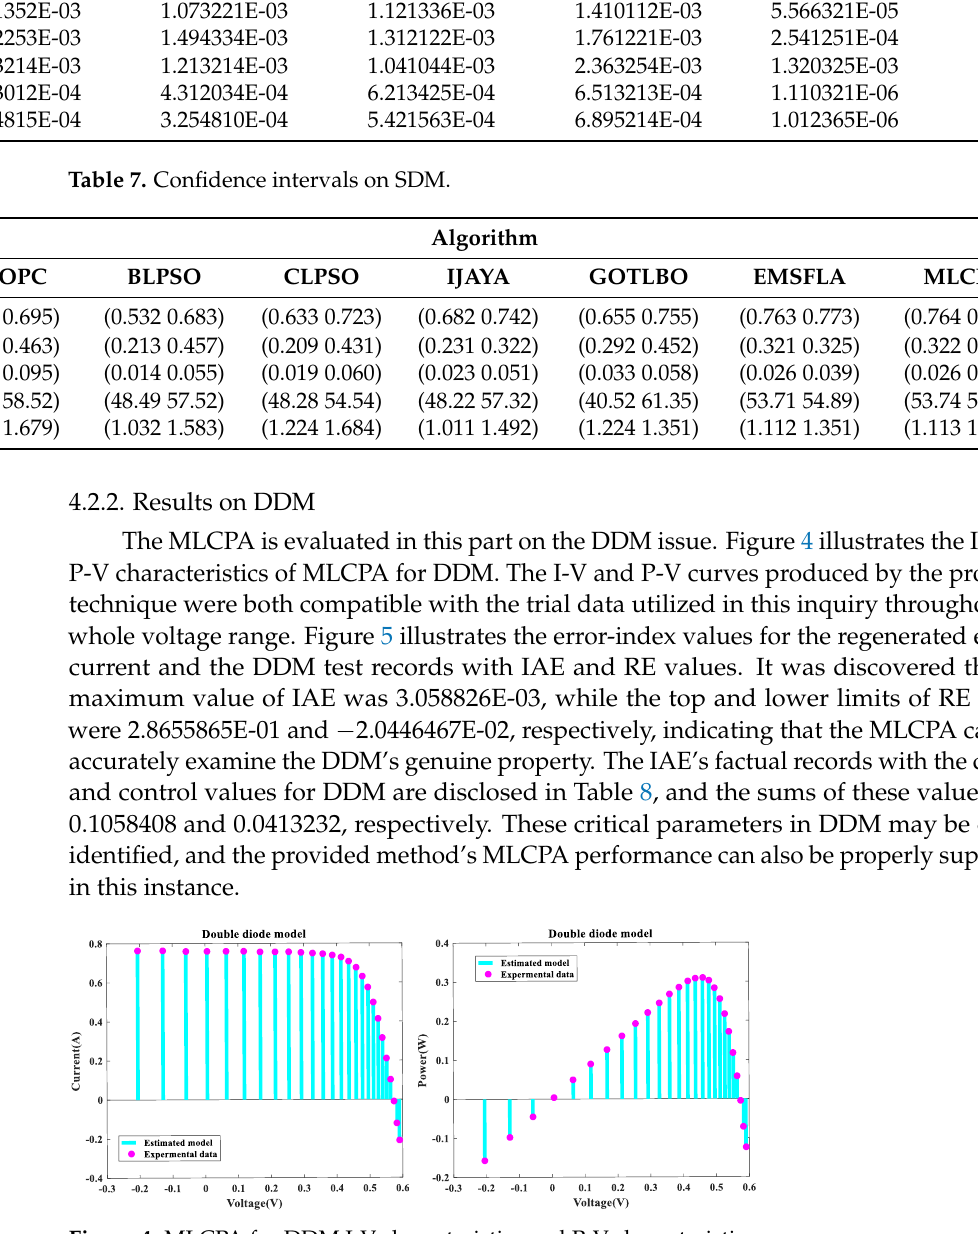
Figure 4. MLCPA for DDM I-V characteristics and P-V